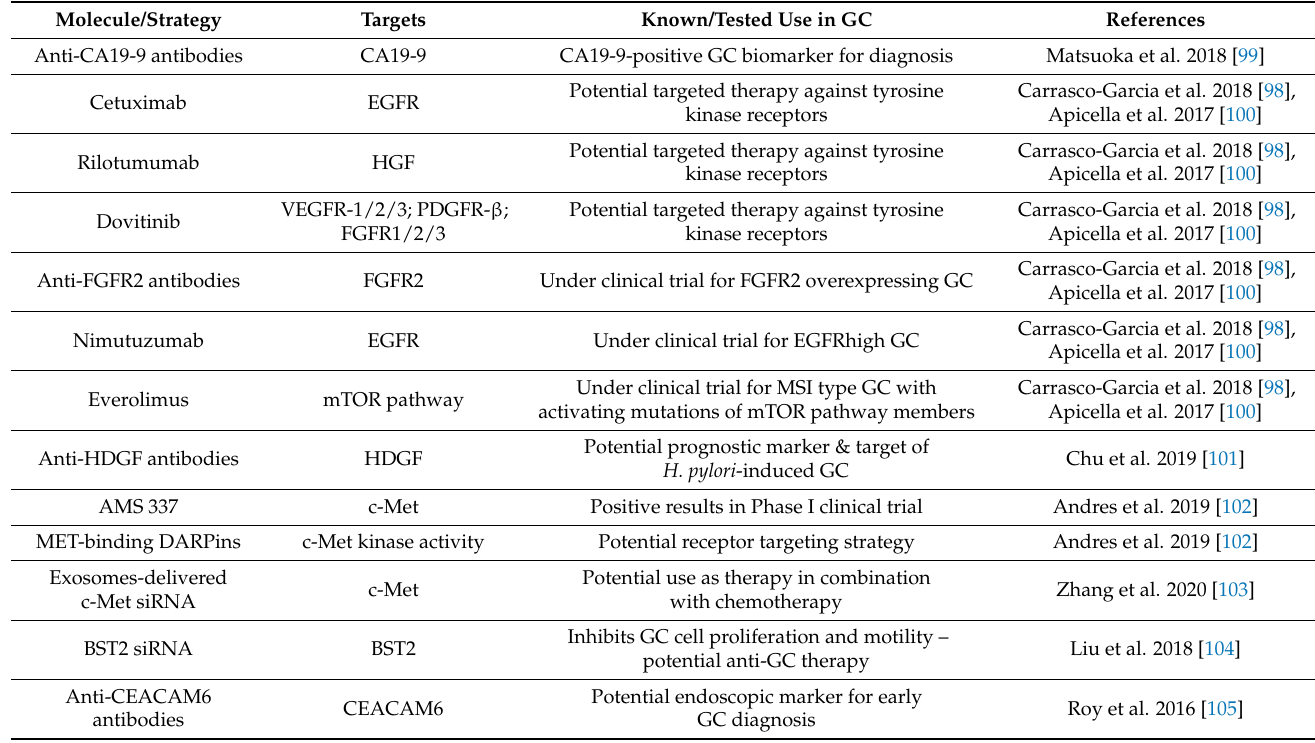
Table 1. Summary of molecules that can be used as potential biomarkers and therapeutic targets for